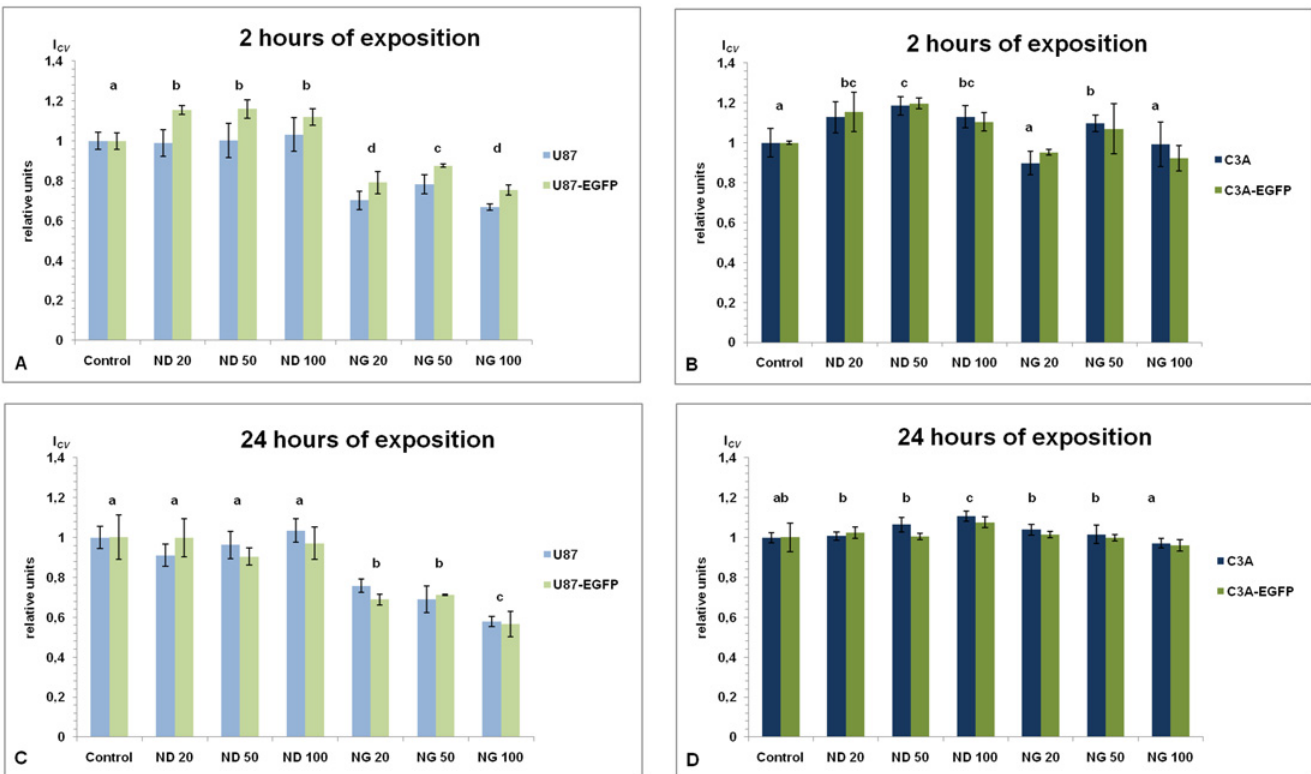
Fig 3. MTT test analysis. U87, U87-EGFP, C3A and C3A-EGFP cells metabolic analysis was performed after 2 and 24 h of exposure to the culture medium containing nanoparticles at different concentrations: diamond 20 μ g/mL (ND 20), 50 μ g/mL (ND 50) and 100 μ g/mL (ND 100), and graphite 20 μ g/mL (NG 20), 50 μ g/mL (NG 50) and 100 μ g/mL (NG 100); nontreated cells were used as a control (Control). Metabolic activity of cells, expressed as I CV , after 2 h of exposure to the culture medium with the above-mentioned different concentrations of diamond and graphite nanoparticles: U87 and U87-EGFP ( A ), and C3A and C3A-EGFP ( B ); and after 24 h of exposure to the culture medium with above-mentioned different concentrations of diamond and graphite nanoparticles: U87 and U87-EGFP ( C ), and C3A and C3A-EGFP ( D ). Data analysis was carried out by two-way ANOVA and the differences between the groups were tested by Duncan ’ s test. Data were averaged from three replicates (n = 3); P < 0.05. No significant interaction (nanoparticles with transduction) was